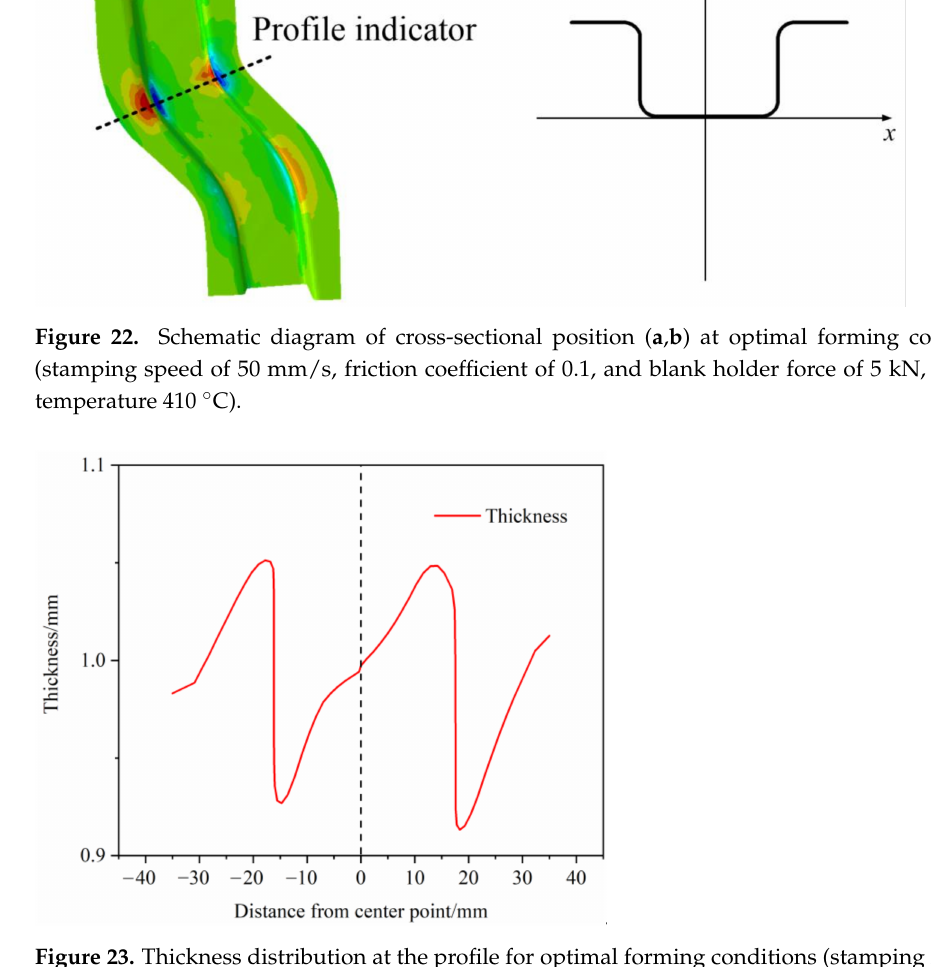
Figure 23. Thickness distribution at the profile for optimal forming conditions (stamping speed of 50 mm/s, friction coefficient of 0.1, and blank holder force of 5 kN, forming temperature 410 ◦ C).